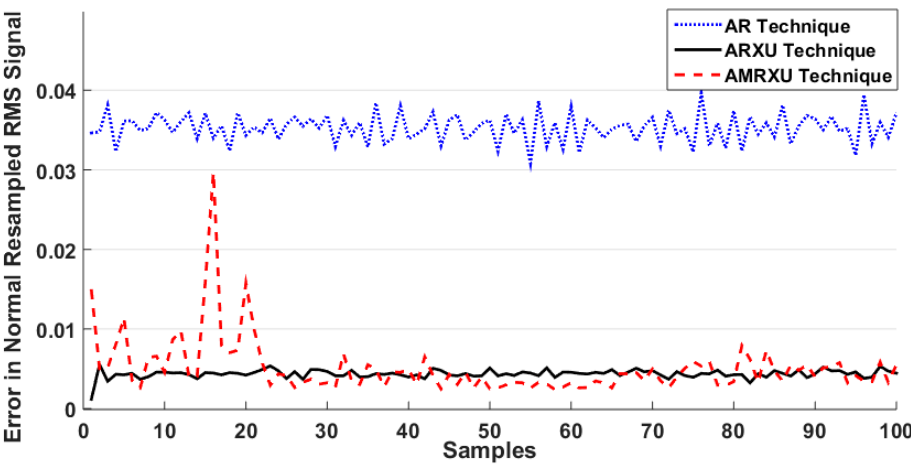
Figure 4. Error in AR, ARXU, and AMRXU techniques from normal resampled RMS signal modeling.